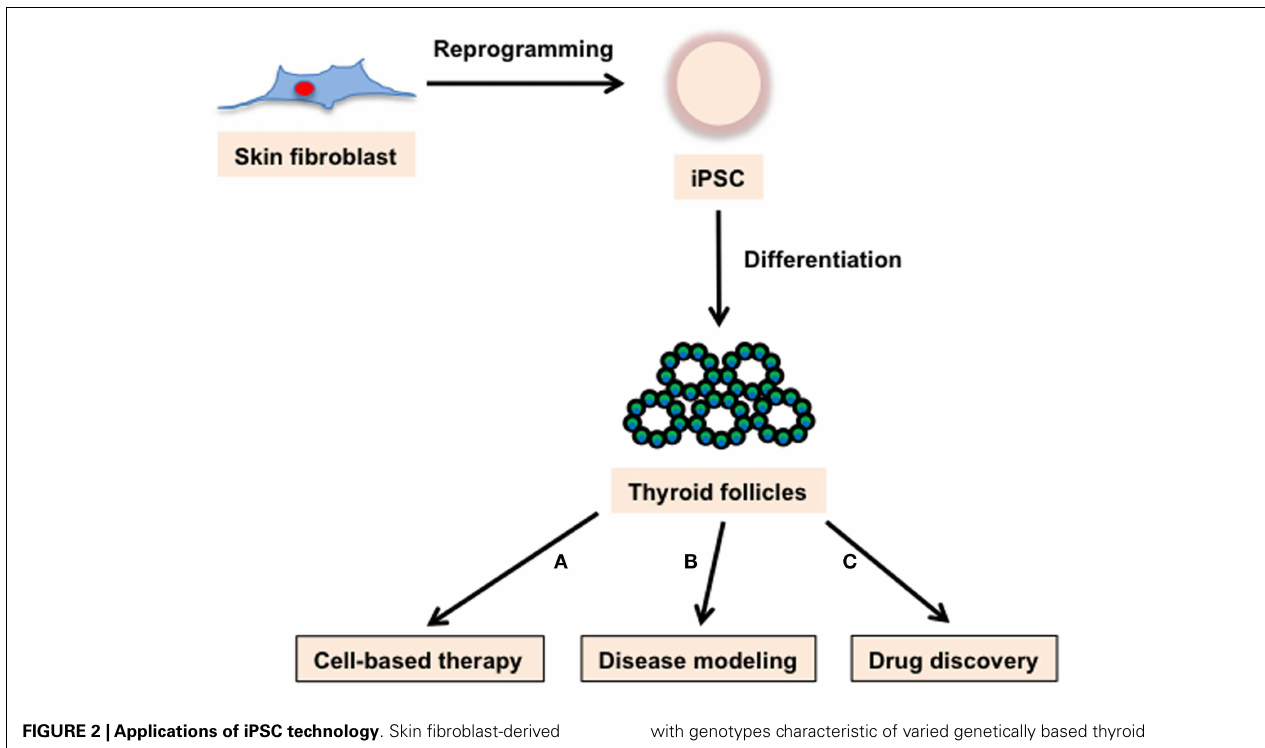
FIGURE 2 |Applications of iPSC technology . Skin fibroblast-derived iPSCs can produce thyroid follicles.These cells can be used for (A) cell-based therapy, (B) disease modeling, and (C) drug discovery. (A) Based on the demonstrated success of ESCs in rescuing thyroid ablated mice, iPSCs derived thyroid follicles have incredible potential as a cell replacement therapy for a variety of thyroid maladies. (B) iPSC lines